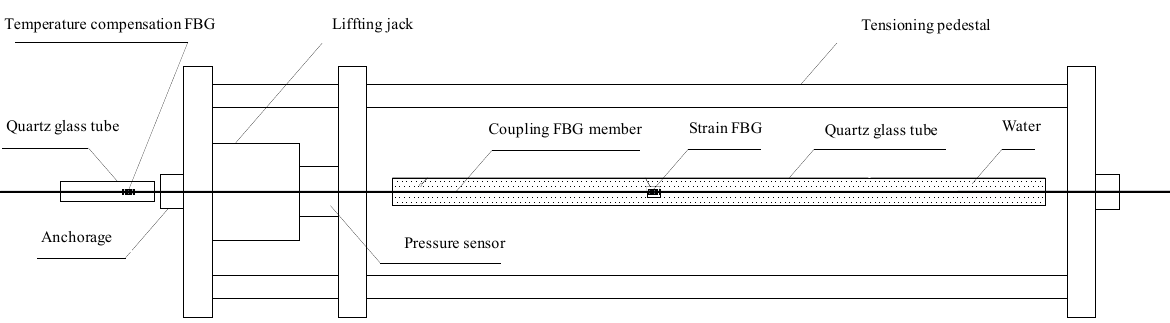
Fig. 8 Schematic diagram of temperature compensation test